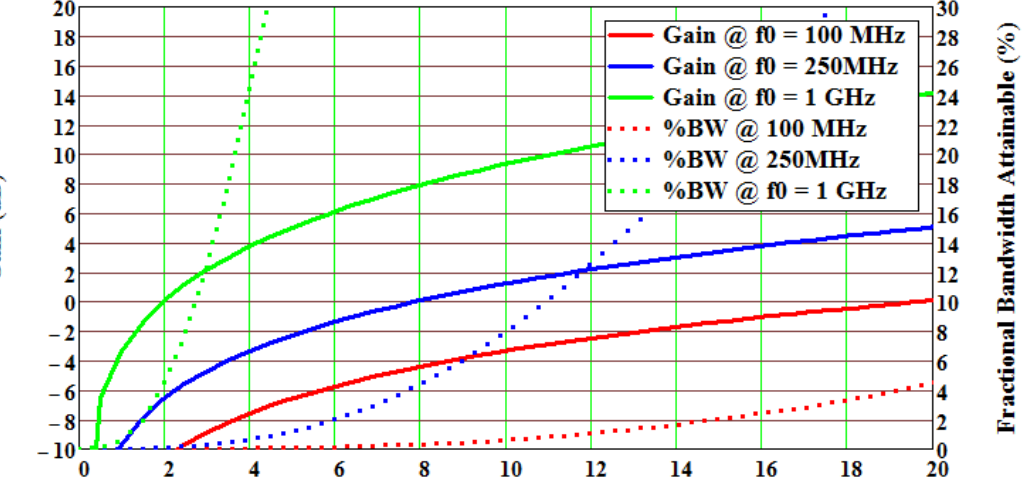
Figure 5. Plots of the approximate gain and fractional bandwidth versus effective antenna radius for an electrically small antenna, from the analysis of Wheeler [11,12]. Predicted gain Equation (solid lines) and fractional bandwidth (dotted lines) are plotted versus antenna radius in